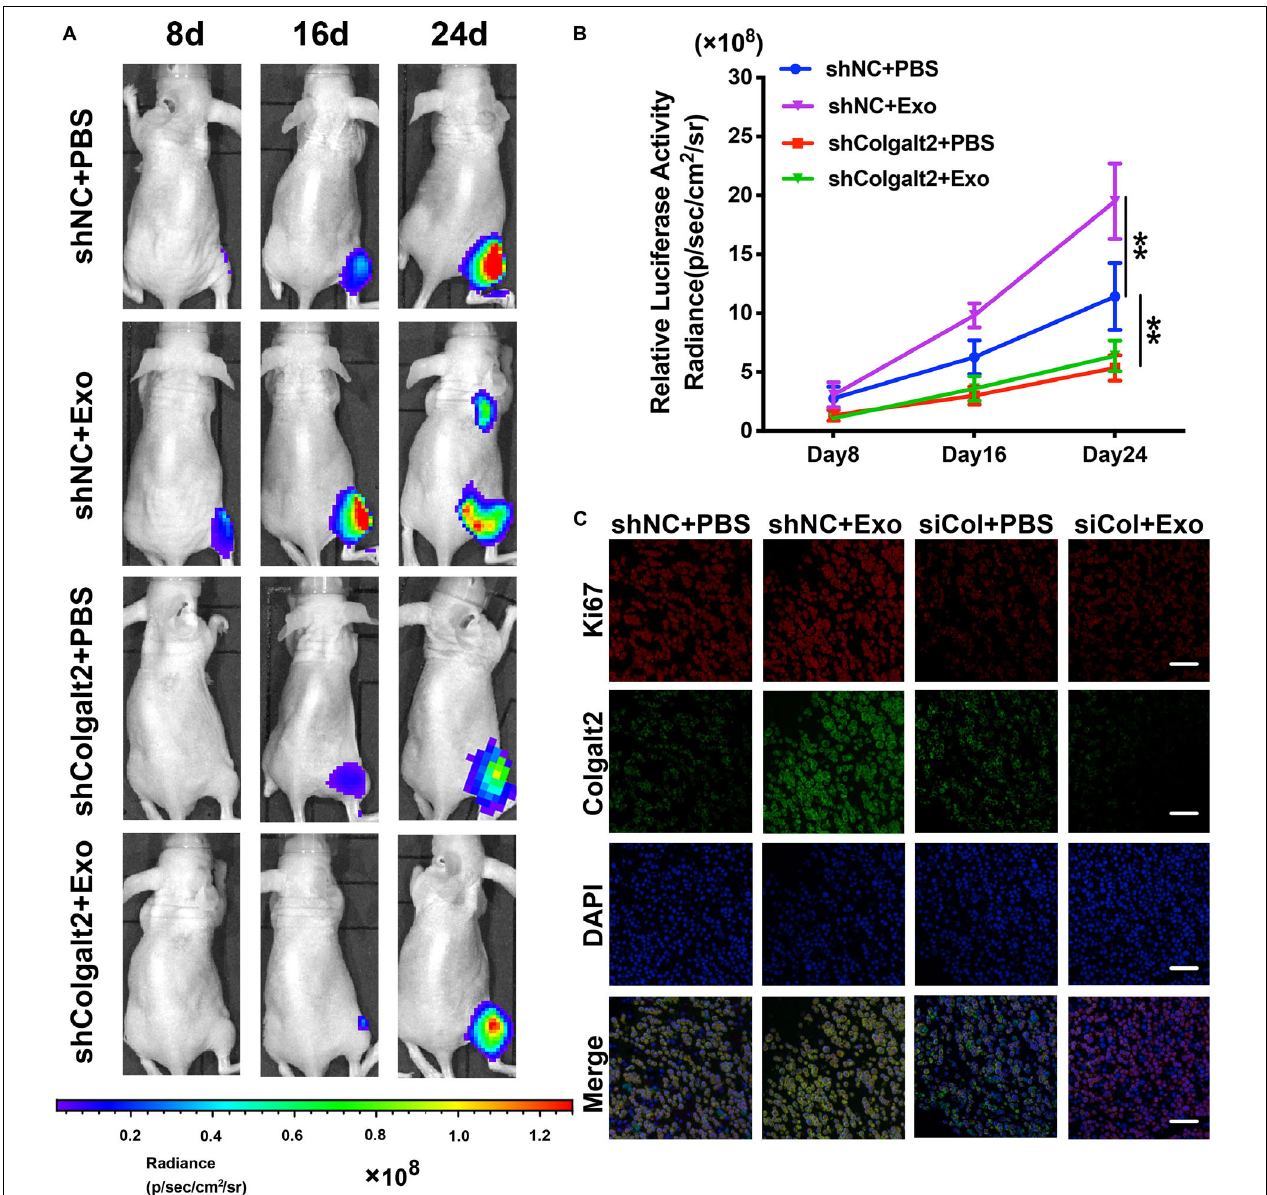
FIGURE 7 | COLGALT2 mediates the promotion effects of ADSC exosomes on osteosarcoma metastasis and growth in models of nude mice. (A) To inspect osteosarcoma xenograft luminescence activity, an in vivo imaging system was applied. The results indicated tumor metastasis and growth. (B) Living Image Software was used to examine the tumor bioluminescence intensity every 8 days. Additionally, the quantitation of the normalized image counts is displayed. (C) The immunohistochemical analysis of COLGALT2 and Ki67 expression in orthotopic tumor xenografts is shown. Scale bar: 25 µ m. ** P < 0.01.